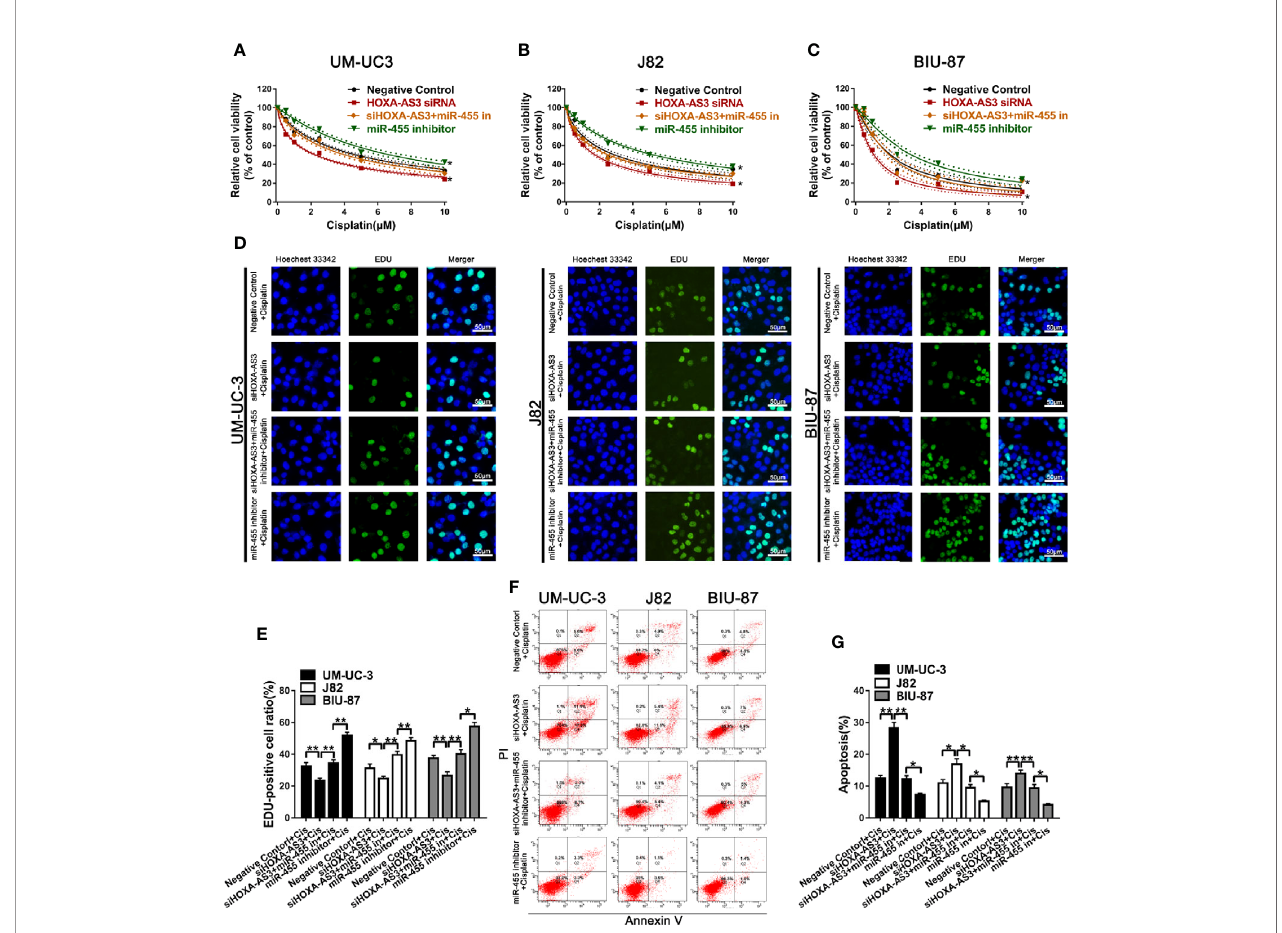
FIGURE 5 | miR-455-5p mediates the regulatory effect of HOXA-AS3 on cisplatin sensitivity. (A – C) Viability of BC cells (CCK-8 assay) treated with different concentrations of cisplatin for 48 h (0, 0.625, 1.25, 2.5, 5, 10 m M) following transfection with HOXA-AS3 small interfering RNA (siRNA), miR-455-5p inhibitor, or HOXA-AX3 plus miR-455-5p inhibitor. *P < 0.05 vs . negative control. (D – E) Cell proliferation of BC cells (EdU staining) after treatment with cisplatin, or combined with HOXA-AS3 siRNA, or miR-455-5p inhibitor, or HOXA-AS3 siRNA plus miR-455-5p inhibitor. *P < 0.05, **P < 0.01, ***P < 0.001. (F , G) Apoptotic rate of BC cells in different treatment groups (Negative siRNA plus cisplatin, HOXA-AS3 siRNA plus cisplatin, HOXA-AS3 siRNA plus miR-455-5p plus cisplatin) detected by fl ow cytometry. *P < 0.05, **P < 0.01, ***P <